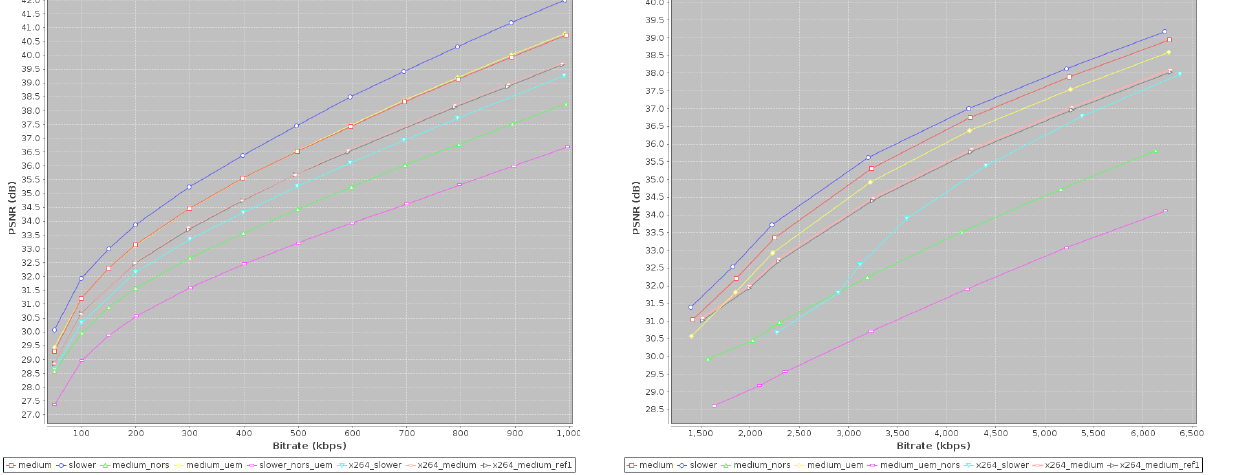
Figure 11: R-D Curves for the ”Camp Pendleton” sequence, with a resolution of 1088x672 pixels and a frame rate of 1 fps.